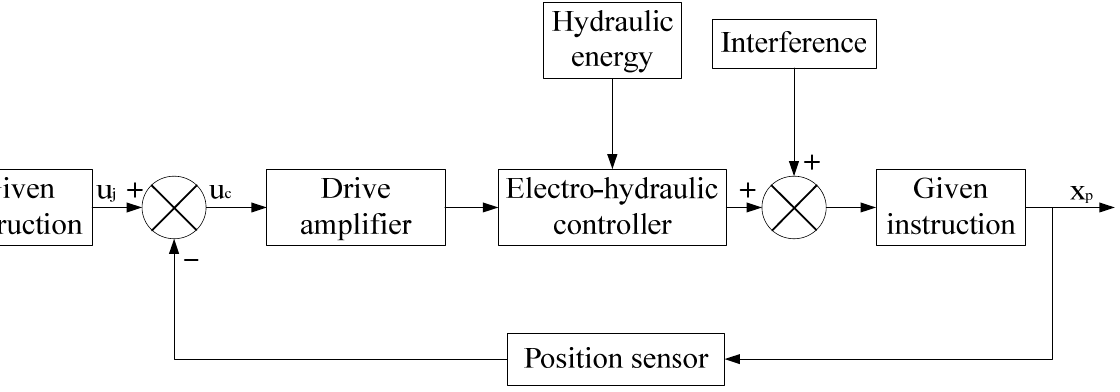
Figure 3. Structure diagram of a large-flow digital development valve. ( a ) Structure diagram of digital valve; ( b ) Sectional view of digital valve.